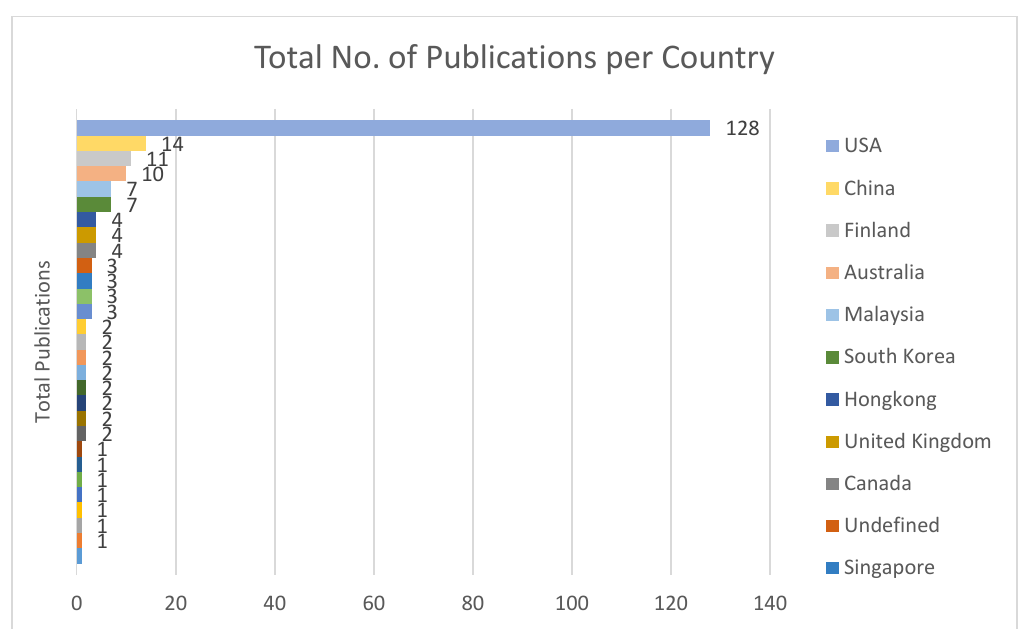
Figure 3. Number of publications per country.